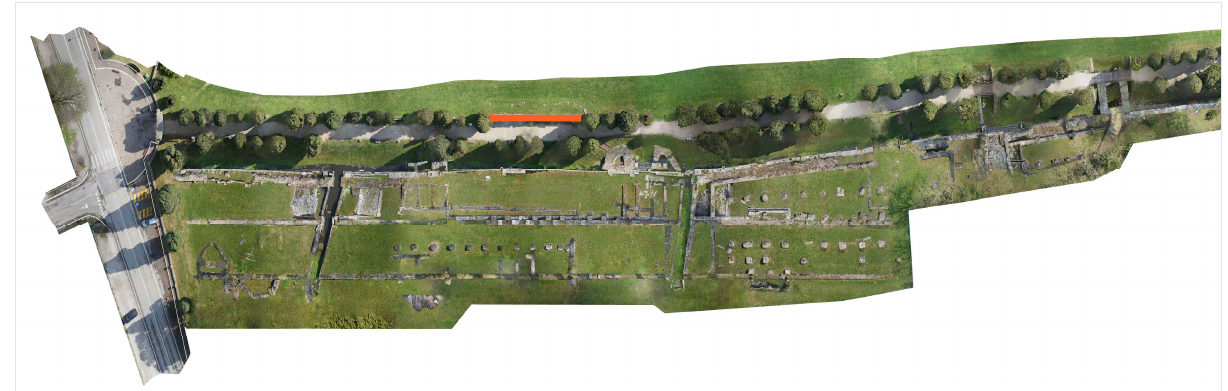
Figure 1. Advanced 3D model of the Roman fluvial port of